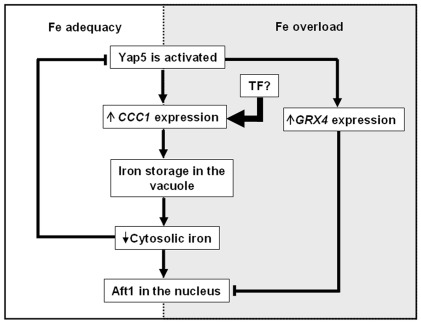
Model for the hypothetical role of Yap5 in iron metabolism.Under Fe-adequate growth conditions Yap5 is active and the main regulator of CCC1 gene expression. The continuous Fe storage will end up with cytoslic Fe depletion and the consequent activation of Aft1 in order to re-establish Fe homeostasis. Under Fe overload, another factor is regulating CCC1 gene expression, bypassing Yap5 regulation. In addition Yap5 transactivation potential is higher and therefore it is able to induce GRX4 gene that together with Grx3 will inhibit Aft1 activity by promoting its nuclear export to the cytoplasm.